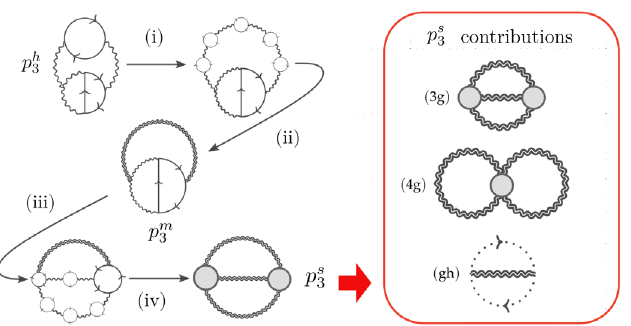
Figure 2. (Left) An illustration of how to arrive at contributions from di ↵ erent momentum scales from Figure 1. An illustration of the renormalization-scale dependence of the cold-QM EoS at N2LO [7]. a hard diagram. When a gluon momentum in a four-loop diagram becomes soft (i), additional self- The cold-QM EoS is shown for the three di ↵ erent choices of the renormalization parameter X = 1 , 2 , 4, energy corrections do not change the order of the diagram. (ii) This soft gluon line can be resummed plotted on top of the regions of viable NS-matter EoSs as determined in Ref. [9] using robust theoretical within the HTL theory, producing the HTL propagator denoted by a thick wavy line and leads to a and astrophysical constraints. These regions are color-coded by the maximal value of the speed of sound three-loop ‘mixed’ contribution if the other gluon momenta are hard. (iii) If the other gluon momenta in squared c 2 obtained at any point along the EoS, with lower max( c 2 ) regions plotted on top of higher s s the diagram also become soft, then the other gluon propagators and interaction vertices must be dressed ones. with additional loops as well, giving rise to (iv) a fully soft HTL contribution to p s two-loop HTL diagrams that contribute to p s